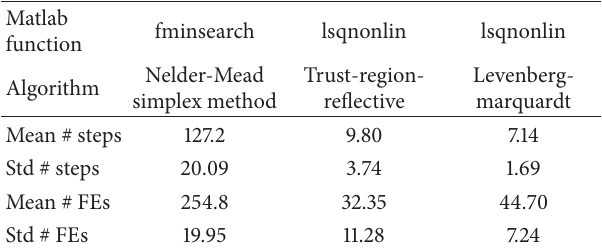
Table 4: Results obtained with different Matlab functions with 𝑅